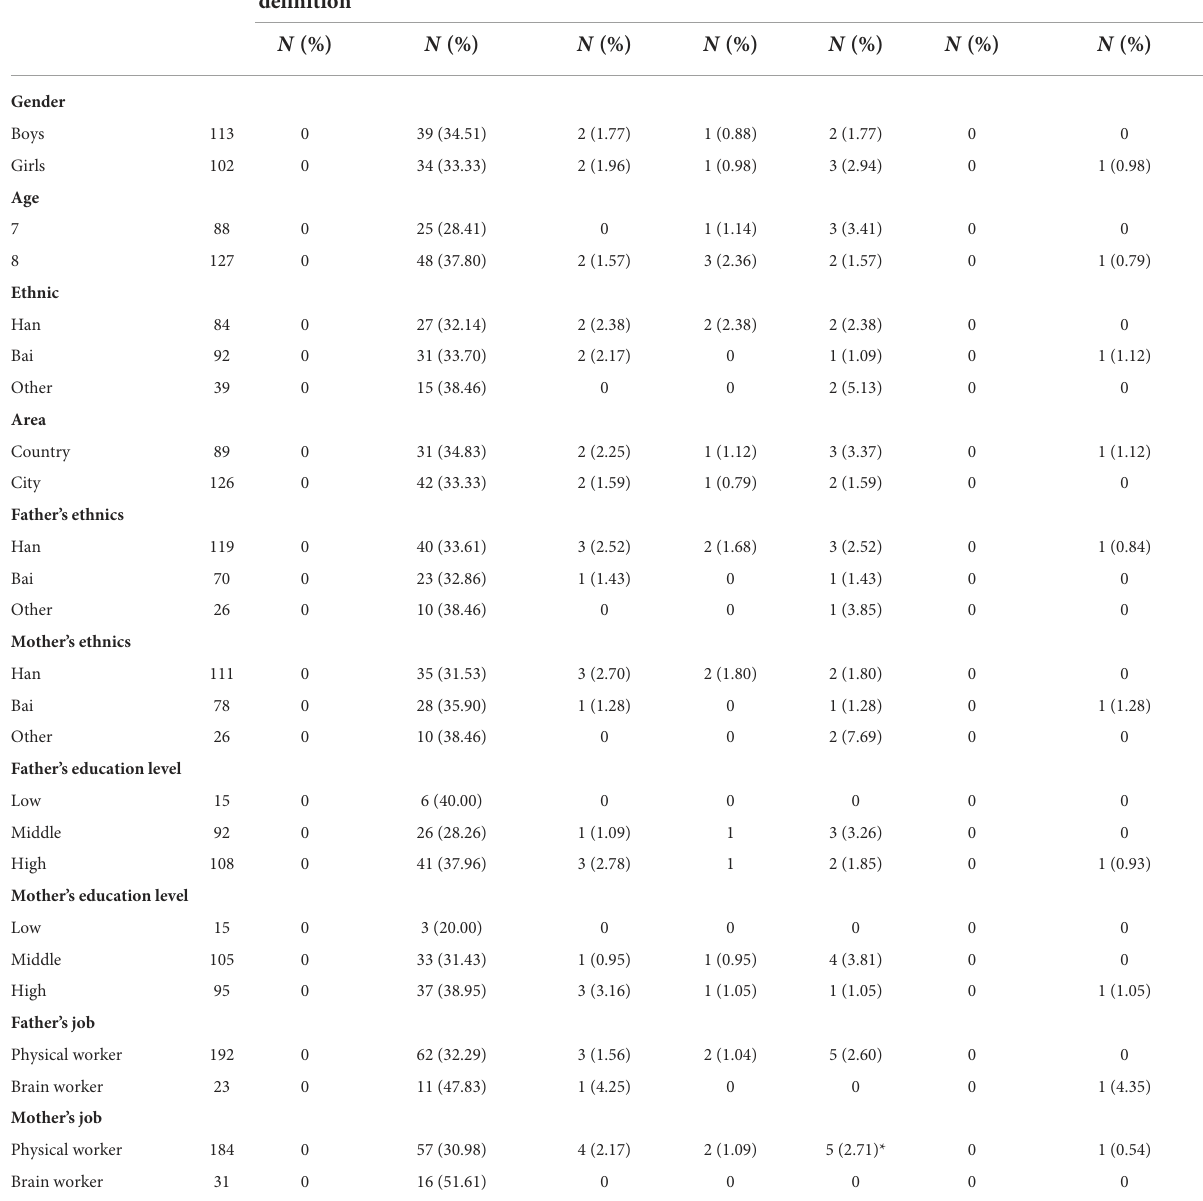
TABLE 1 The correct rate of stroke knowledge of primary school students in pre-intervention in Dali, Yunnan, China. Subsection N Stroke